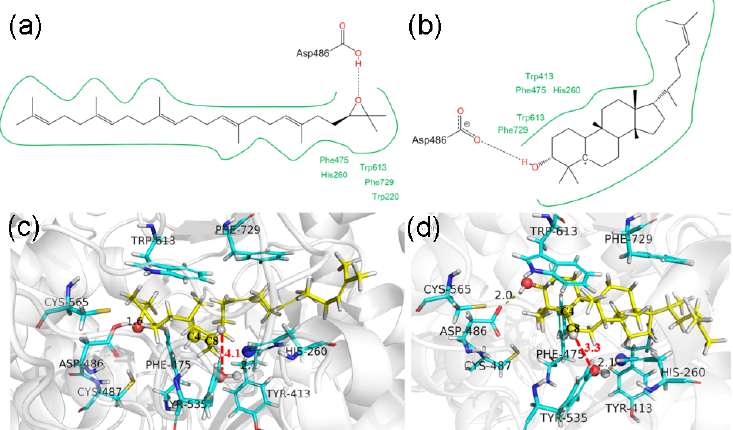
Figure 1. The two primary energetically favored binding clusters of the 2,3-oxidosqualene and C-4 cation in the active sites of SgCS from docking studies. ( a ) 2D docked view of ligand SgCS with 2,3-oxidosqualene receptor; ( b ) 2D docked view of ligand SgCS with C-4 cation receptor; ( c ) 2,3-oxidosqualene and protein interaction hydrogen bond interaction view; ( d ) C-4 cation and protein interaction hydrogen bond interaction view. 3D representation of SgCS is shown in cartoon (gray), the sticks with cyan carbon atoms represent amino acid residues and the sticks with yellow carbon atoms represent 2,3-oxidosqualene and C-4 cation compounds. The red dotted lines denote hydrogen bonds.